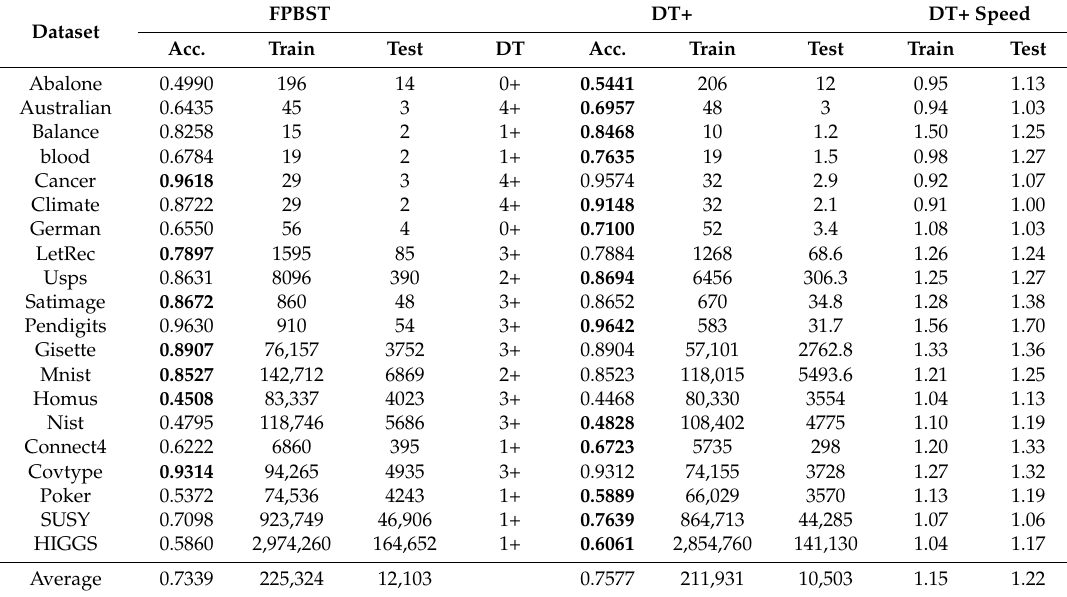
Table 8. Accuracy (Acc.) and speed-up results (training and testing phases) of FPBST compared to the proposed DT0+ to